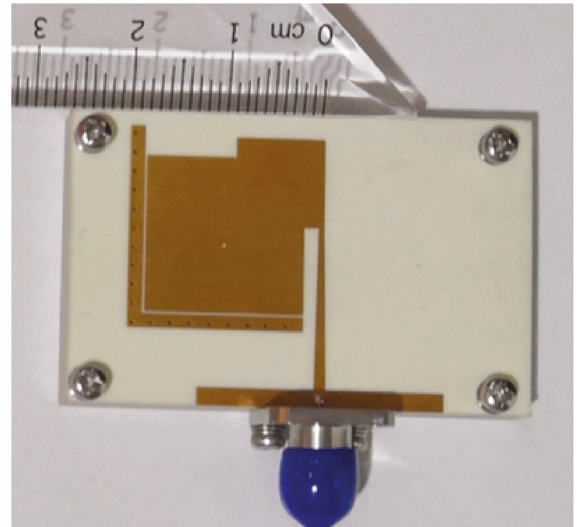
Figure 10: Photograph of proposed antenna.